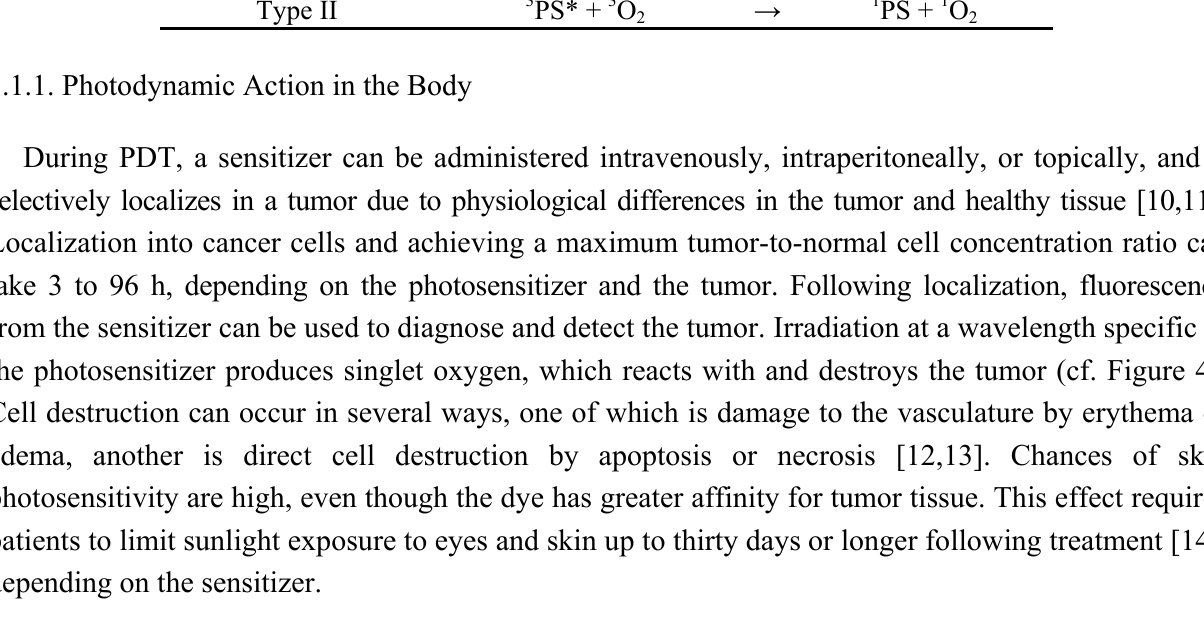
Figure 4. Schematic representation of photodynamic therapy (PDT) treatment of a malignant tumor